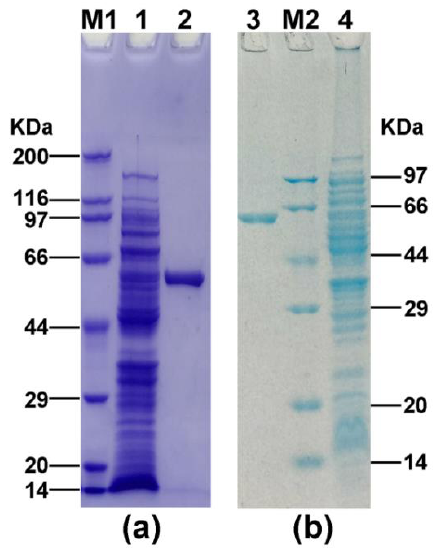
Figure 2. SDS-PAGE analysis of AlsS1 ( a ) and AlsS2 ( b ) expressed in E. coli . Lane M1, premixed protein marker (Broad) (TaKaRa, Dalian, China); lane 1, induced E. coli BL21-S1; lane 2, purified AlsS1; lane 3, purified AlsS2; lane M2, premixed protein marker (Low) (TaKaRa, Dalian, China); lane 4, induced E. coli BL21-S2.